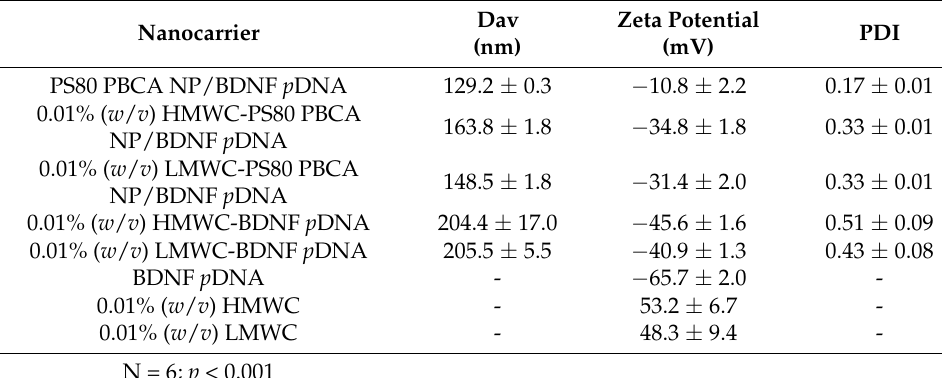
Table 2. The average diameter (Dav), zeta potential, and polydispersity index (PDI) of the